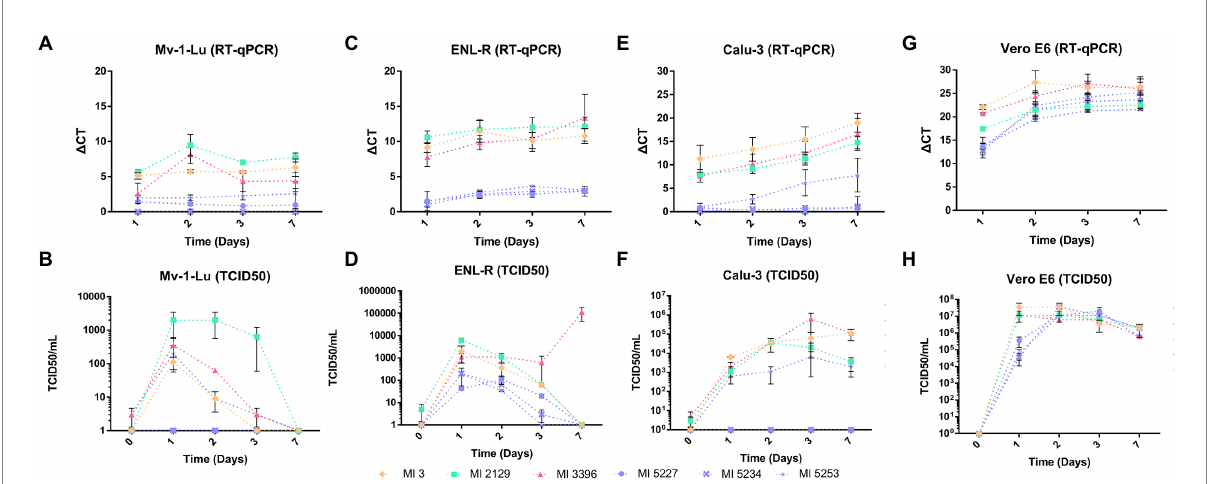
FIGURE 2 SARS-CoV-2 release and its viral titer over a week of infection in different cells. The viral release was defined by the relative quantification of the viral genome by RT-qPCR and the median tissue culture infectious dose (TCID50) of cell supernatants recovered from each cell line starting from 1 to 7 days postinfection (d.p.i). The Δ Ct was calculated from the values obtained in the assay using one replicate from two different experiments. The TCID50/ml values were obtained from fresh supernatant inoculum into Vero E6 cells, using four replicates per dilution. (A) Genomic viral release quantification ( Δ Ct) from Mv-1-Lu cells supernatant; (B) Infective particle quantification (TCID50/ml) on Mv-1-Lu cell supernatant; (C) Genomic viral release quantification ( Δ Ct) from ENL-R cell supernatant; (D) Infective particle quantification (TCID50/ml) in ENL-R cells supernatant; (E) Genomic viral release quantification ( Δ Ct) from Calu-3 cell supernatant; (F) Infective particle quantification (TCID50/ml) in Calu-3 cell supernatant; (G) Genomic viral release quantification ( Δ Ct) from Vero E6 cell supernatant; (H) Infective particle quantification (TCID50/ml) in Vero E6 cell